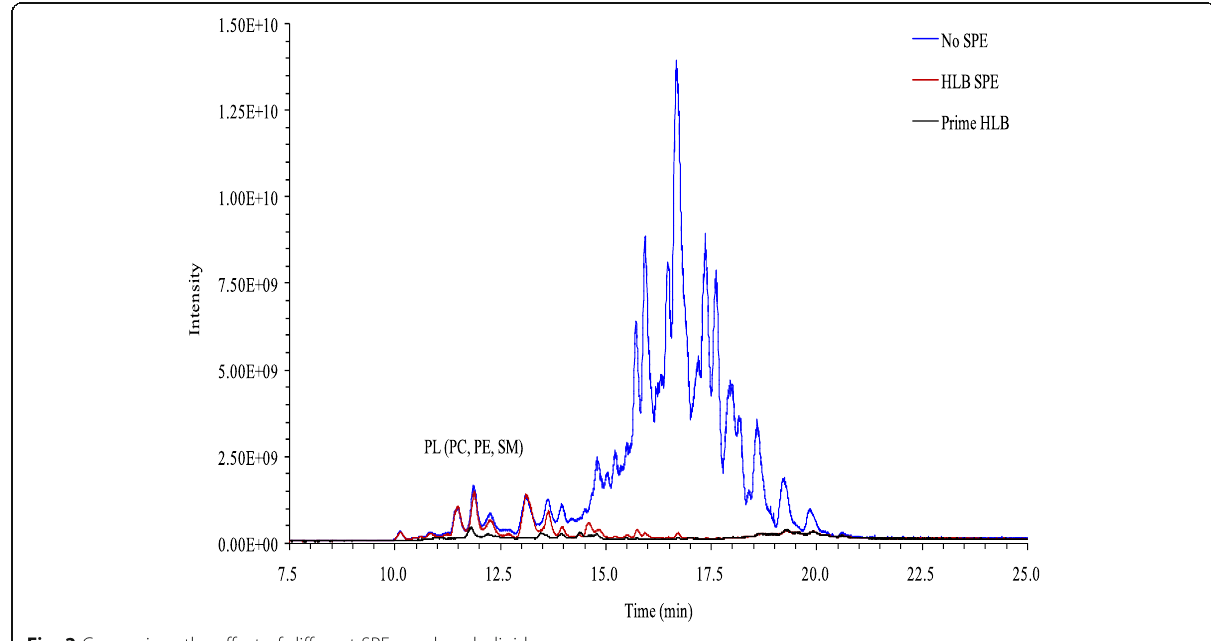
Fig. 2 Comparison the effect of different SPE on